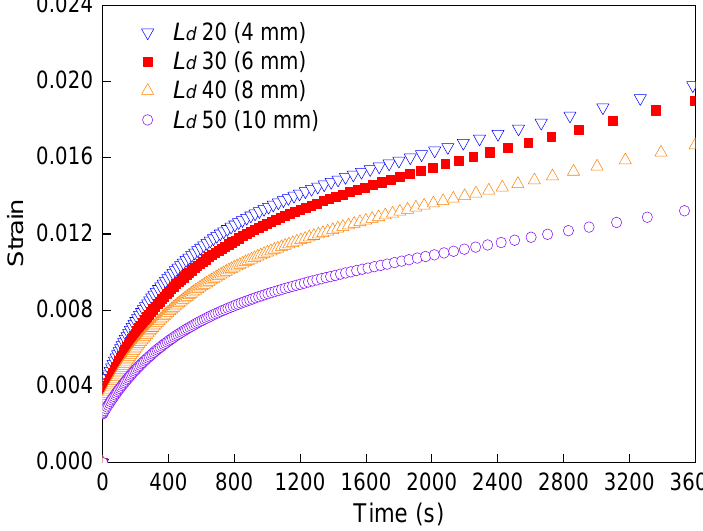
Figure 16. Flexural–tensile rheological values of the model under different BF aspect